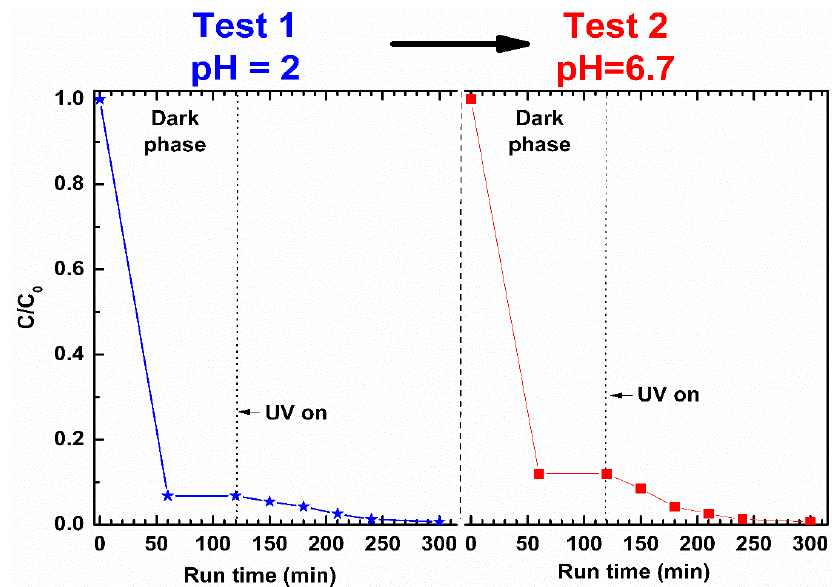
Figure 10. Toluene concentration in aqueous solutions, at pH = 2 ( left ) and pH = 6.7 ( right ), treated with 2ZnO/s-PS δ -form aerogel.